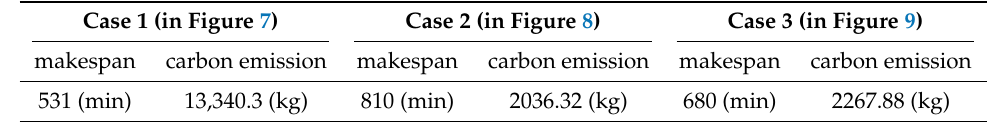
Table 4. Results comparisons of Instance 24.